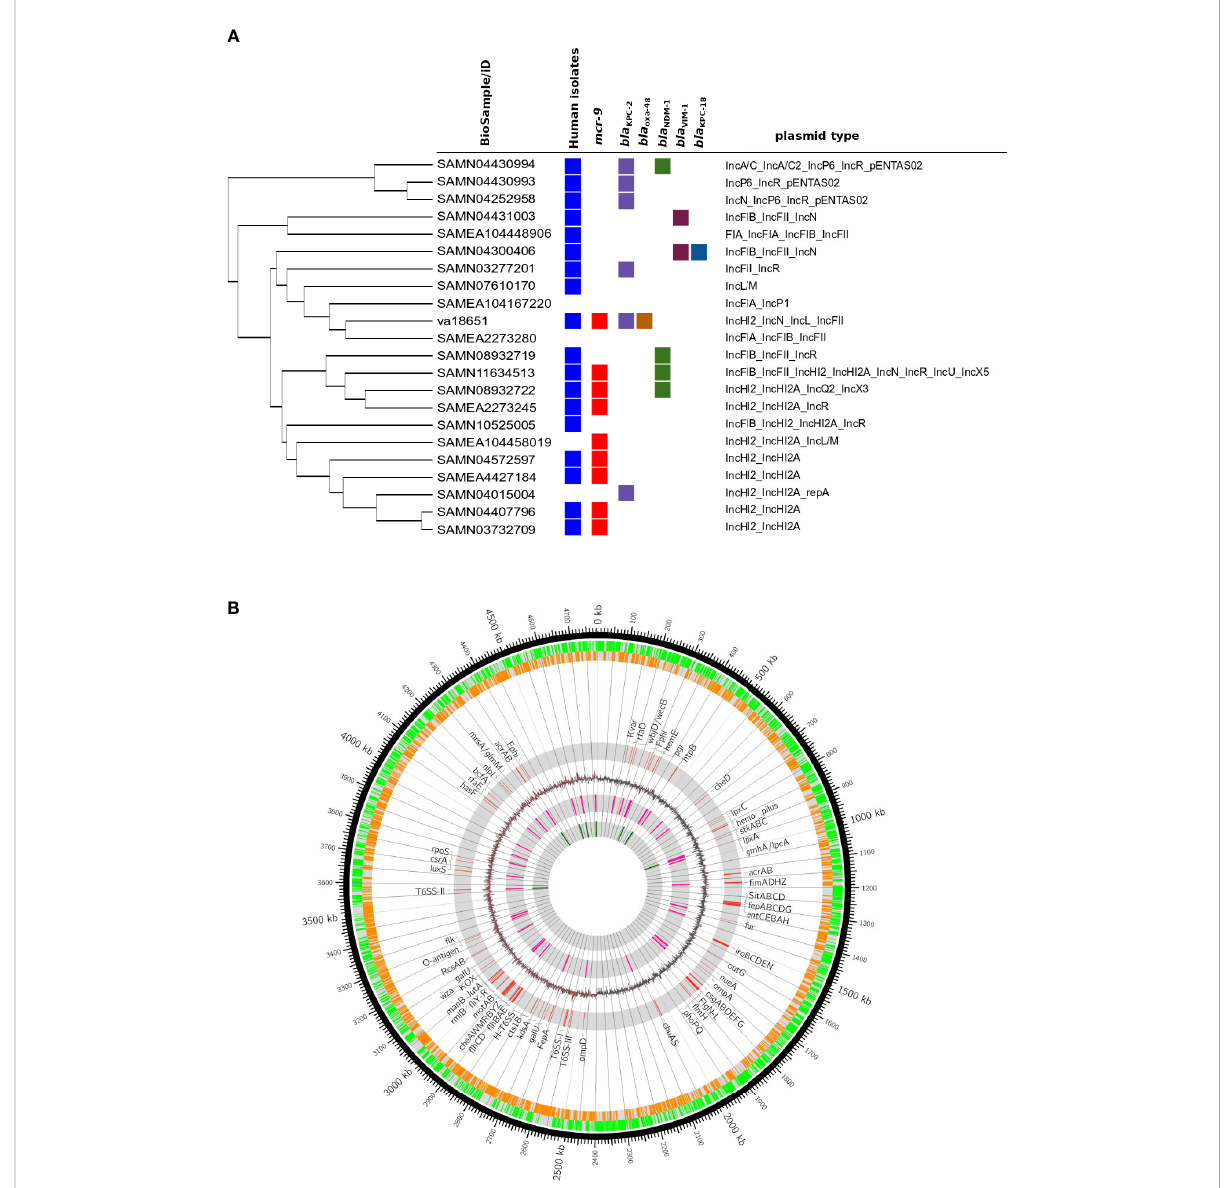
FIGURE 1 Genomic features of extensive drug-resistant Enterobacter xiangfangensis va18651. (A) Phylogenomic comparison of the va18651 to publicly available genomes of 21 ST88 isolates. The va18651 encoded mcr-9, blaKPC-2, and blaOXA-48 genes on three different plasmids with type IncHI2, IncN, and IncL, respectively. (B) Chromosomal features of Enterobacter xiangfangensis isolate va18651. The innermost to outermost (gray) circles indicate the respective locations of rRNA, tRNA, GC-skew, virulence genes, forward – reverse genes, and an ideogram indexing base pairs. The isolate va18651 carried all virulence genes on the chromosome while almost all antibiotic resistance genes were found on the